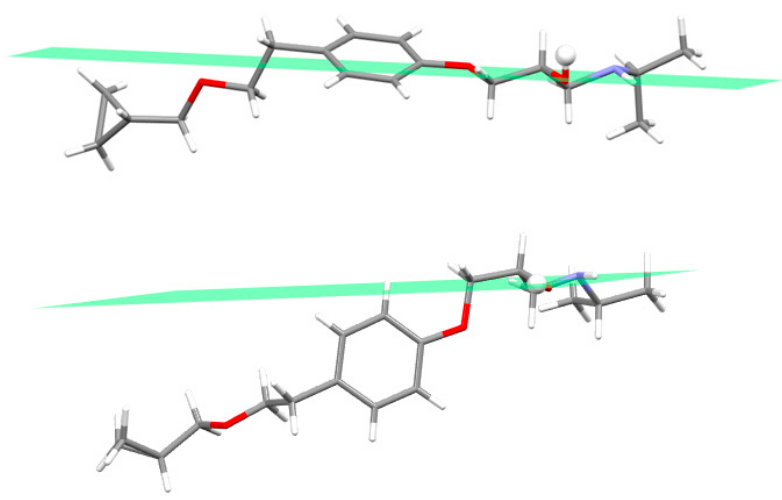
Figure 4. Betaxolol molecules in BE_I ( top ) and BE_IV ( bottom ) highlighting the relative position of the mean plane (in green) passing through the OCCNH atoms and the OH hydrogen atom. For sake of clarity only the set of coordinates having the highest occupancy factor has been reported.